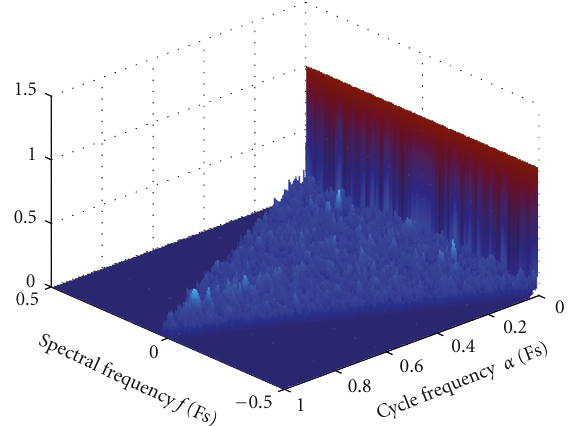
Figure 6: SOF of a QPSK signal in an AWGN Channel at low (0dB) SNR, with 1/Ts = Fs/10, Fc = 0.25 Fs, no. of samples = 4096.